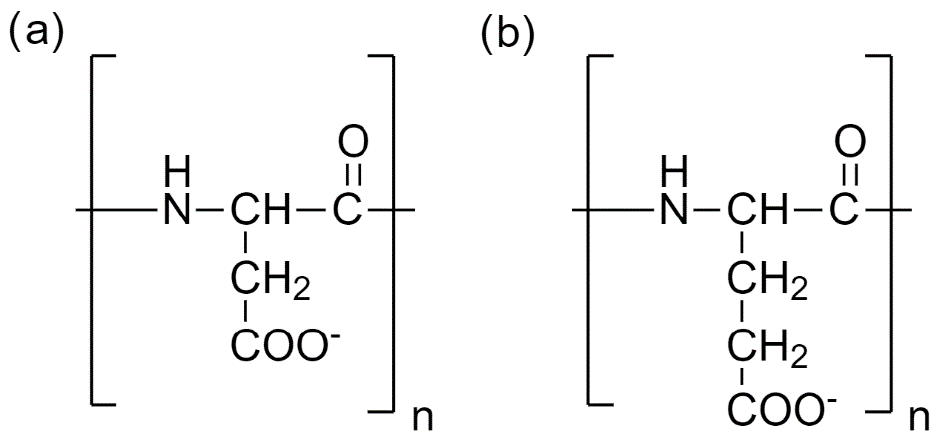
Figure 2. ( a ) PASA and ( b ) PGA chemical structures. The degree of polymerization is denoted by n. In our simulations, n = 32.